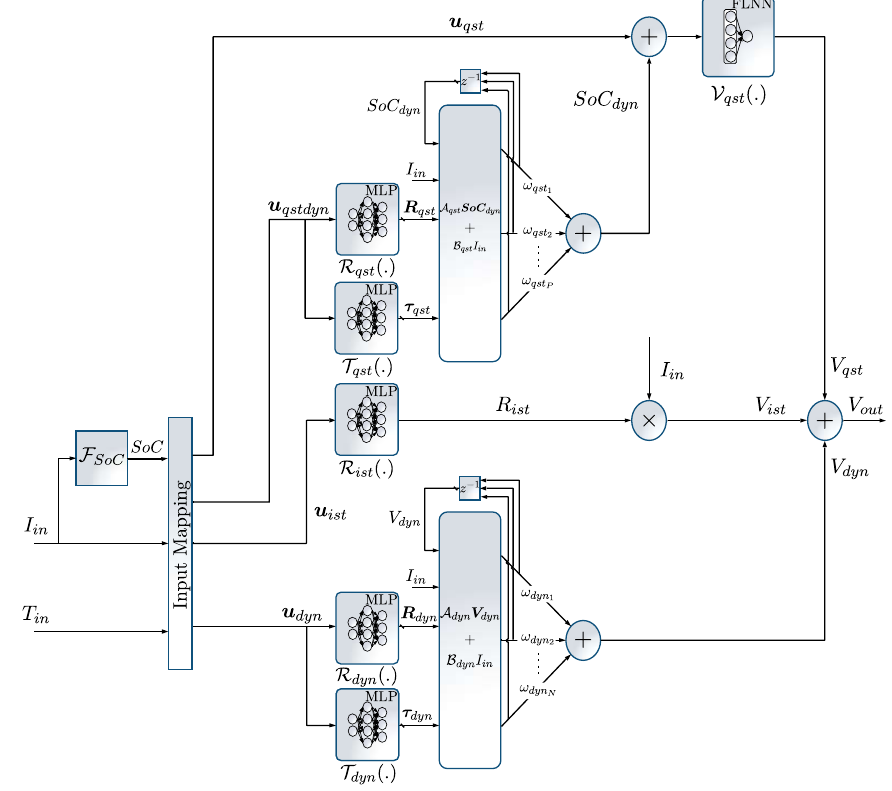
Figure 8. PI-ENNC block